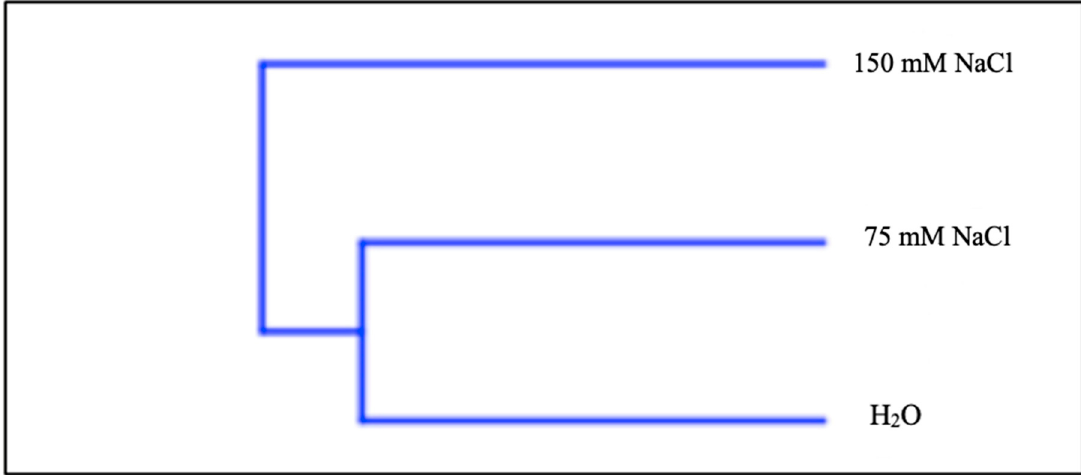
Figure 3. Dendrogram of the hierarchical cluster analysis (HCA) of the VOCs at di ff erent gradients of salinity.